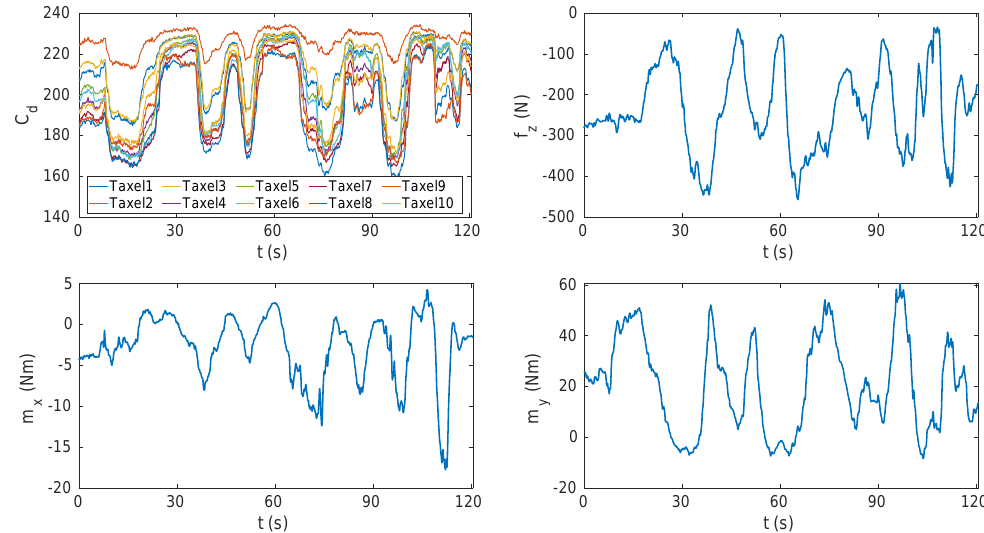
Figure 7. Capacitances measured by one triangle (i.e., 10 taxels), vertical force and horizontal moments measured by the sensorised